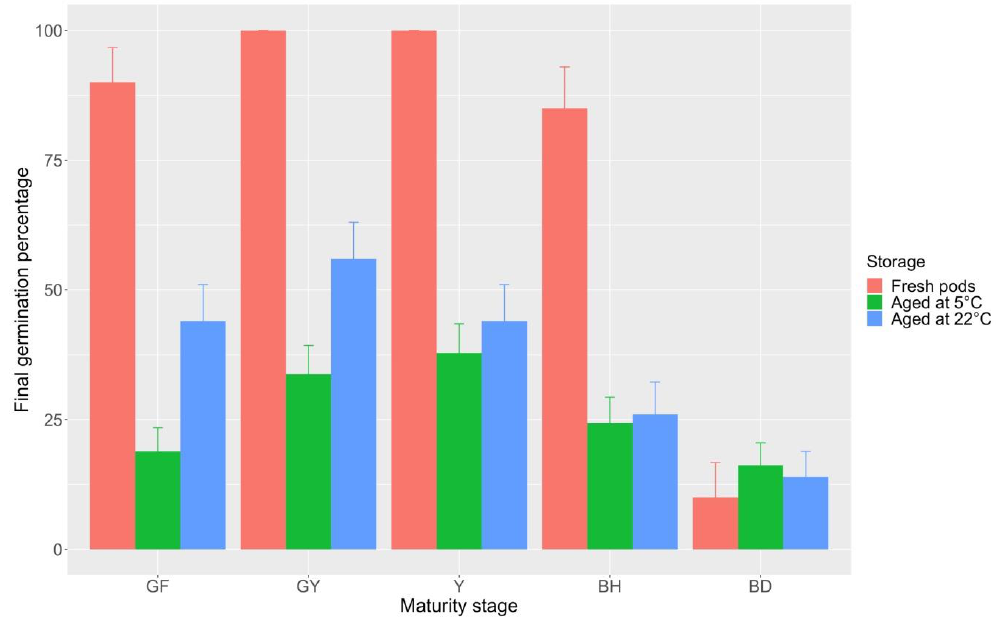
Figure 9. Final germination percentage at 20 °C incubation temperature for B. bituminosa seeds at different pod maturity stages, at harvest time (fresh) and after 420 days of storage at 5 ± 1 and 22 ± 2 °C. Vertical bars represent standard errors. GF = green full; GY = green yellow; Y = yellow; BH = brown hydrated; BD = brown dehydrated.